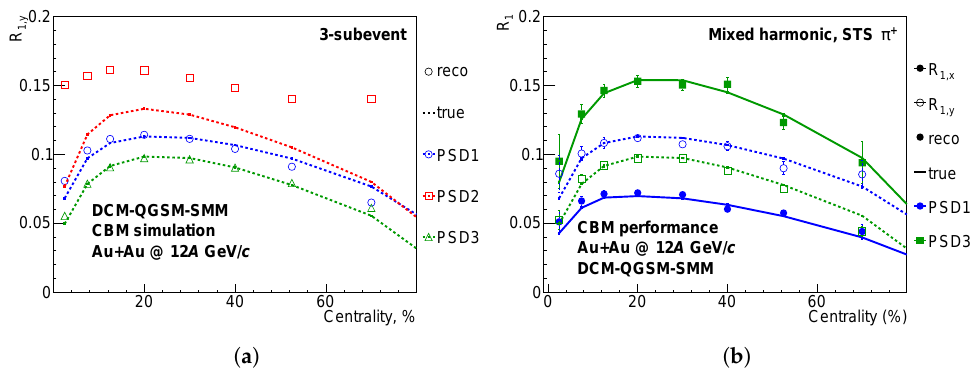
Figure 3. Resolution correction factors for PSD subevents calculated with ( a ) 3-subevent and ( b ) mixed-harmonic methods. The lines show the true values obtained using reaction plane angle from the event generator.